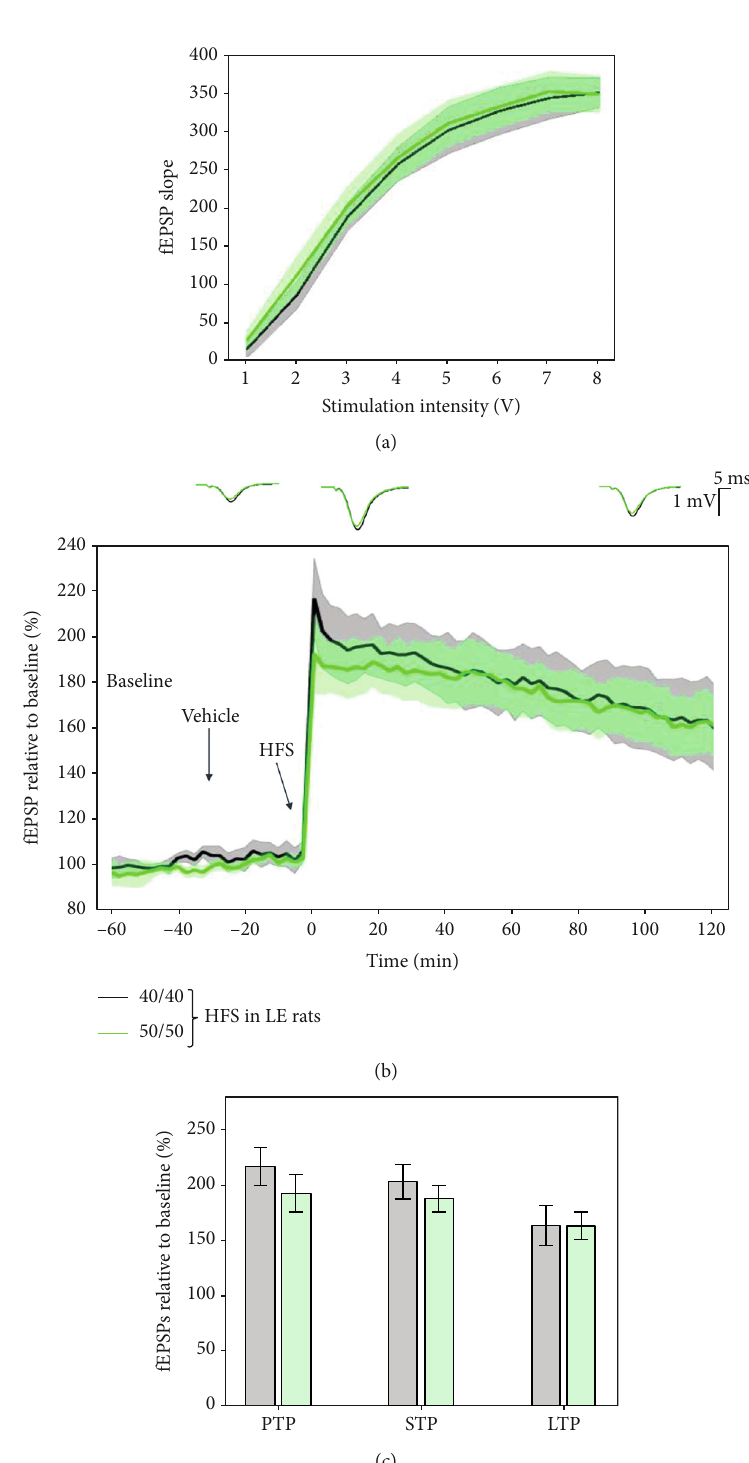
Figure 3: Di ff erential synaptic LTP response induced by the 40/40 and 50/50 HFS protocols in LE rats. (a) Average input/output curves between stimulation voltage and fEPSP slope overlap and show no signi fi cant di ff erence in basal synaptic excitability. (b) fEPSPs were enhanced compared to baseline following 40/40 HFS (black, n = 8 ) and 50/50 HFS (green, n = 11 ) to a similar level. LTP induced by HFS was high throughout the whole 2-hour posttetanisation; however, there was no signi fi cant di ff erence between the LTP response induced by both 40/40 and 50/50 HFS protocols. Data are presented as means ± 95 % confidence intervals . Outsets above LTP curves represent average waveform fi eld potentials during 30 min baseline prior to tetanisation and 0-30 min and 90-120 min posttetanisation. Horizontal bar: 1mV; vertical bar: 5ms. (c) PTP, STP, and LTP responses are presented as means ± 95 % confidence intervals